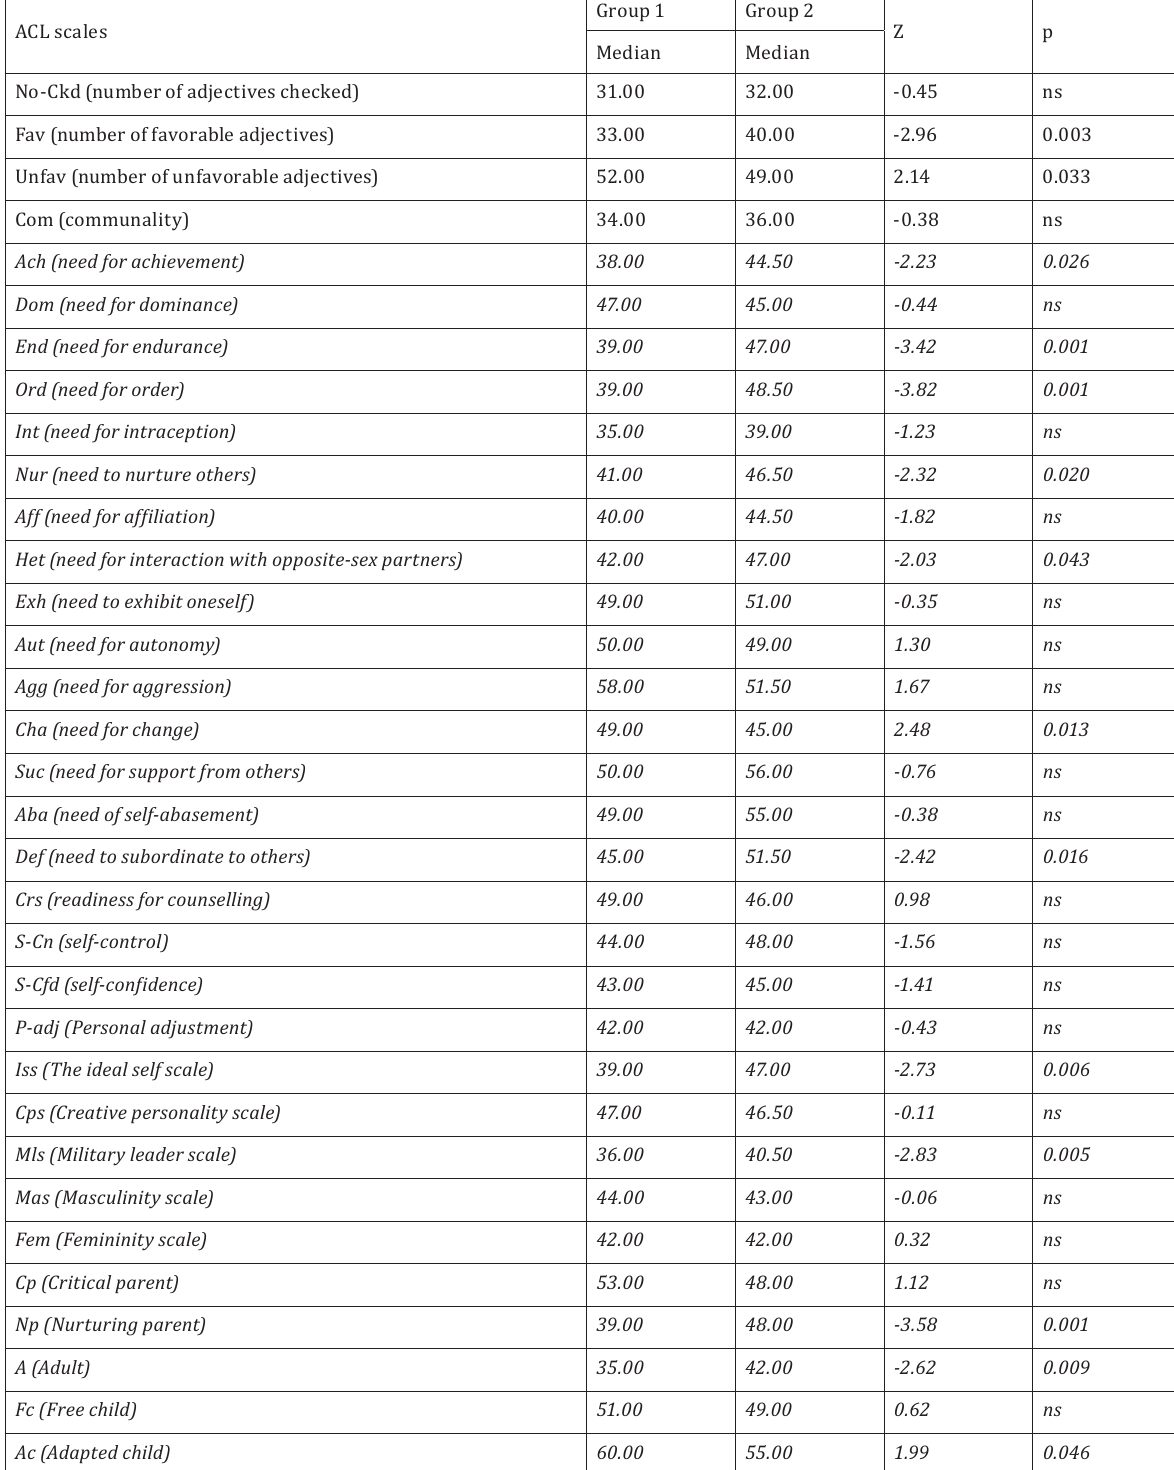
Table 2. Scores obtained in the ACL by the subjects in groups 1 and